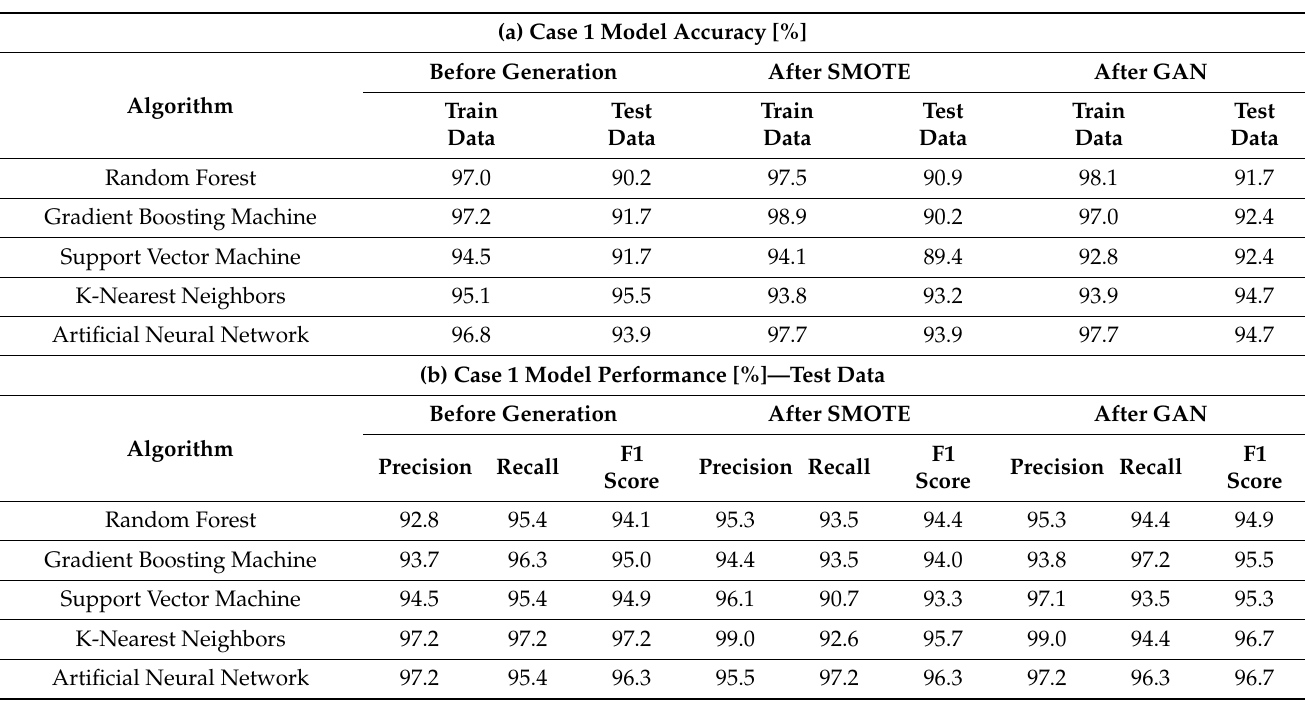
Table 2. Fault detection model performance with Case 1; ( a ) model accuracy with training data and test data and ( b ) model performance with test data.